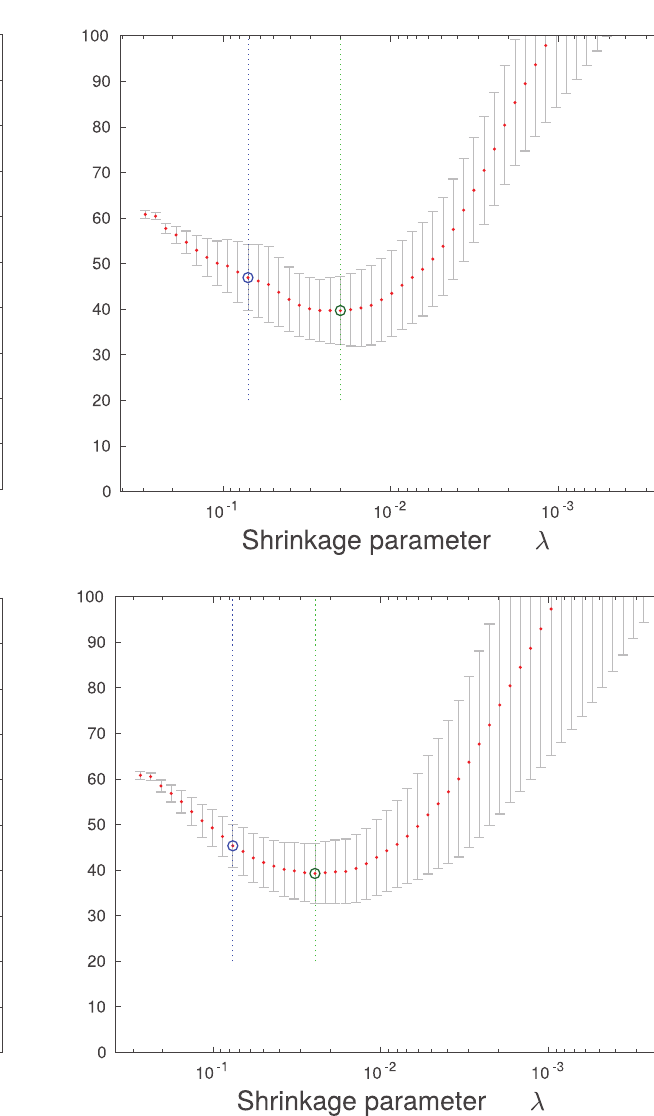
Fig 6. Training curves for classification of Alzheimer’s disease vs . a healthy diagnosis (left column) and Alzheimer’s disease vs . MCI (right column). The graphs on the top row arise from when the path signature method is used to derive features, and the graphs on the bottom row from the log signature method. In each case the graph shows the optimisation of the Lasso shrinkage parameter λ using 10-fold cross validation, where the value of λ increases from right to left. Deviance is a measure of the estimate of the expected negative likelihood of the parameter applied to new data. The green circle and vertical line locate the minimum cross validation error, and the blue circle and vertical line to the left locate the value of λ with minimum cross-validation error plus one standard deviation.